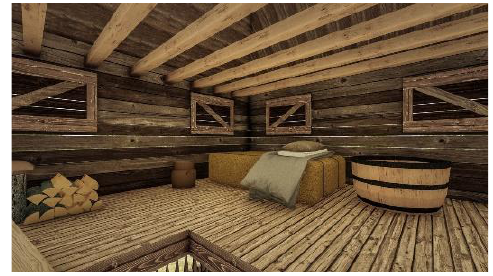
Figure 12. Interior of the guard room [70].